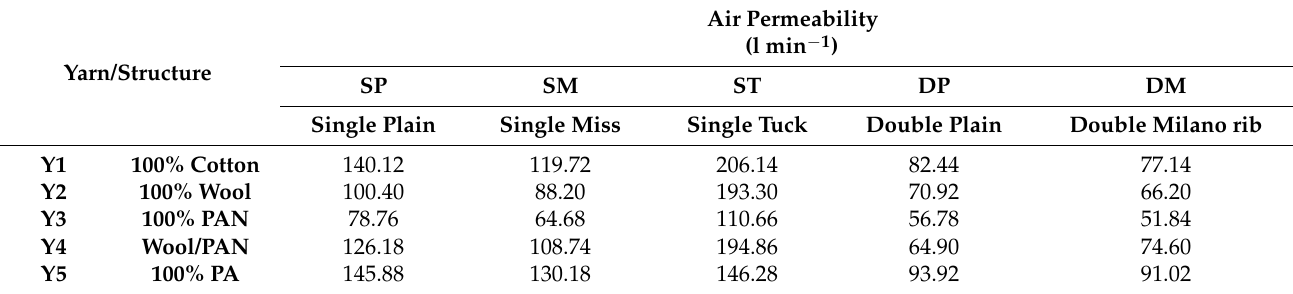
Table 6. Air permeability of knitted